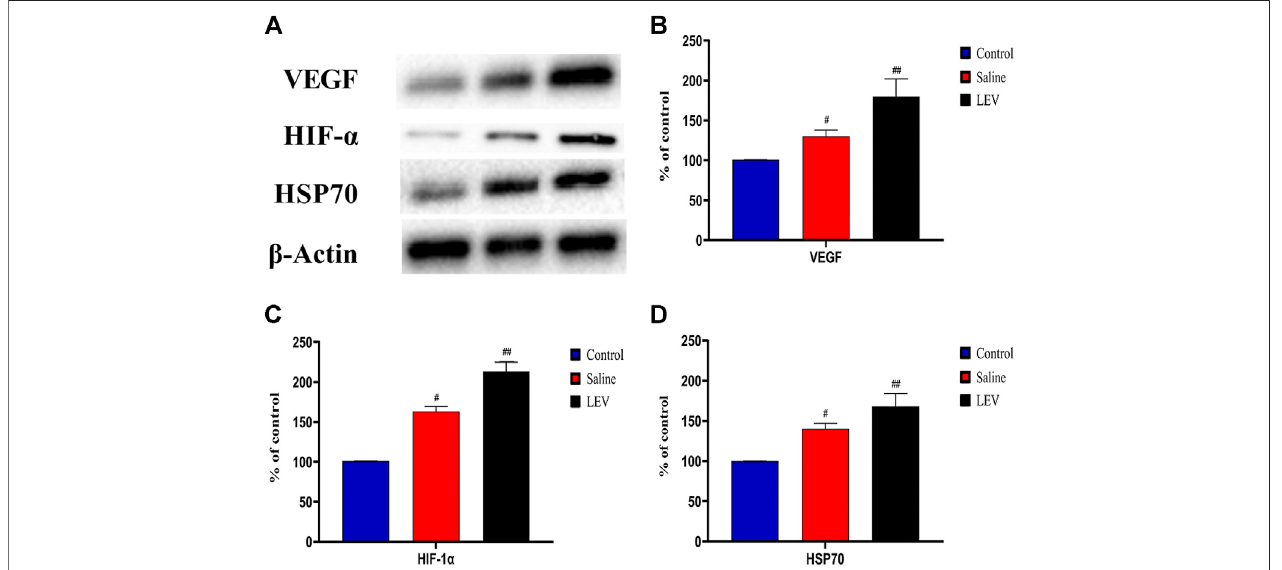
FIGURE 7 | Levetiracetam (LEV) increased the levels of vascular endothelialgrowth factor (VEGF), hypoxia-inducible factor-1 α (HIF-1 α ), and heat shock protein 70 (HSP70)inthecerebralcortexofmiddlecerebralarteryocclusion(MCAO)ratsonday14. (A) TheproteinlevelsofVEGF,HIF-1 α ,HSP70,and β -actinweremeasuredby Westernblot analysis. (B,C) Quantitative results ofVEGF, HIF-1 α , and HSP70. N (cid:1) 12per group. # p < 0.01 compared tothe control group; ## p < 0.01 compared to the saline group.